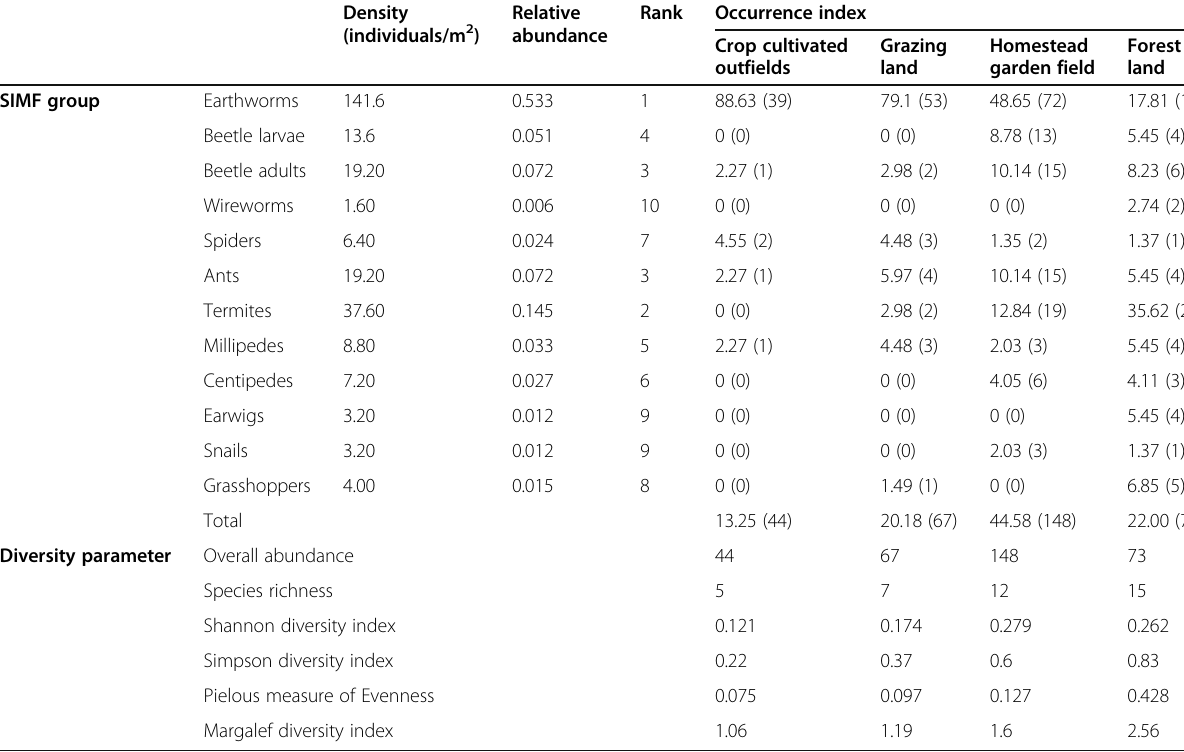
Table 2 The diversity parameters of SIMF at Shenkolla watershed, south central Ethiopia